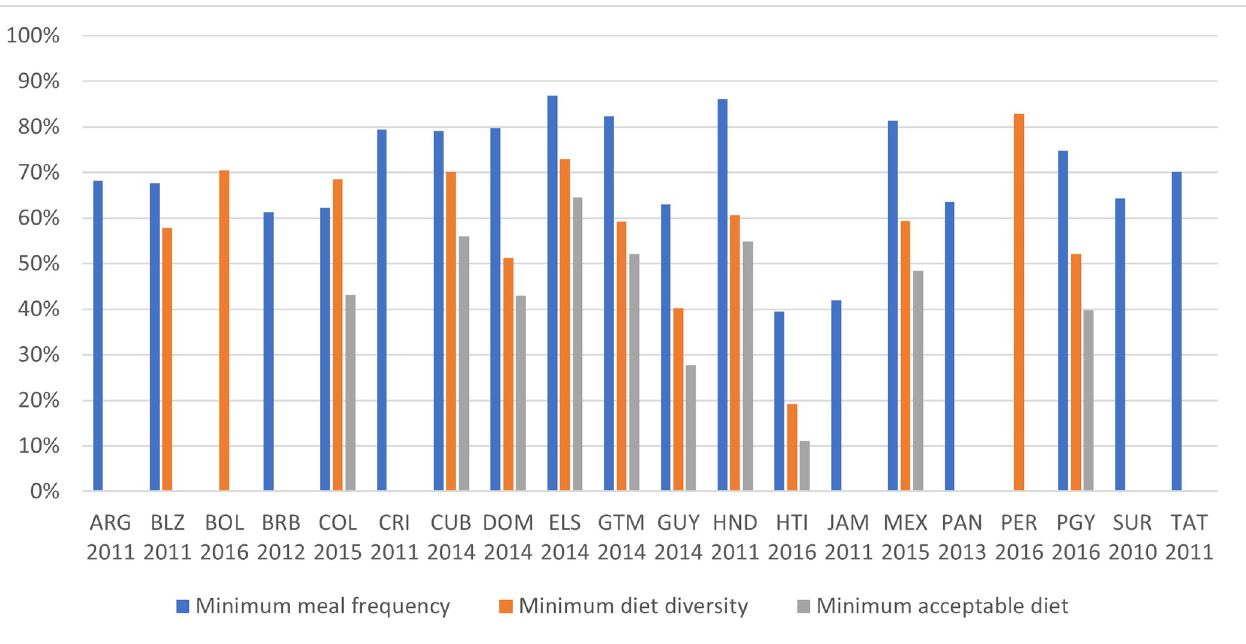
Fig 4. Adequacy of children’s diets in Latin American and the Caribbean countries. Note: The figure shows the prevalence of minimum meal frequency, minimum diet diversity and minimum acceptable diet among children 6–23 months for each country using the latest available data since 2010. Abbreviations: ARG: Argentina, BLZ: Belize, BOL: Bolivia, BRB: Barbados, COL: Colombia, CRI: Costa Rica, CUB: Cuba, DOM: Dominican Republic, ELS: El Salvador, GTM: Guatemala, GUY: Guyana, HND: Honduras, HTI: Haiti, JAM: Jamaica, MEX: Mexico, PAN: Panama, PER: Peru, PRY: Paraguay, SUR: Suriname, TAT: Trinidad and Tobago. Source: Authors’ calculations based on UNICEF Global